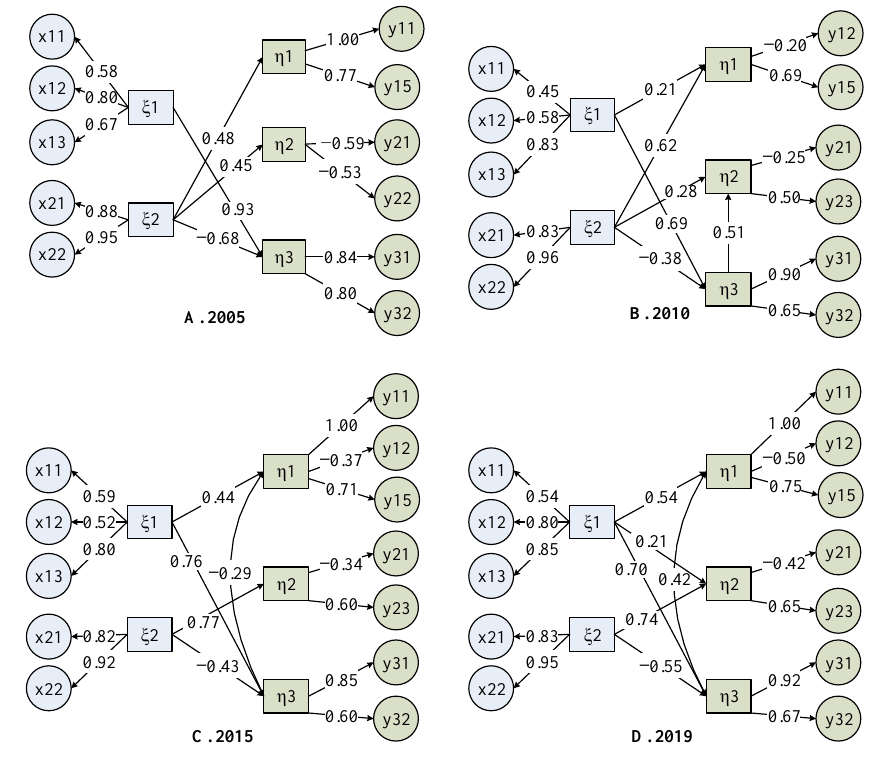
Figure 5. SEM results.